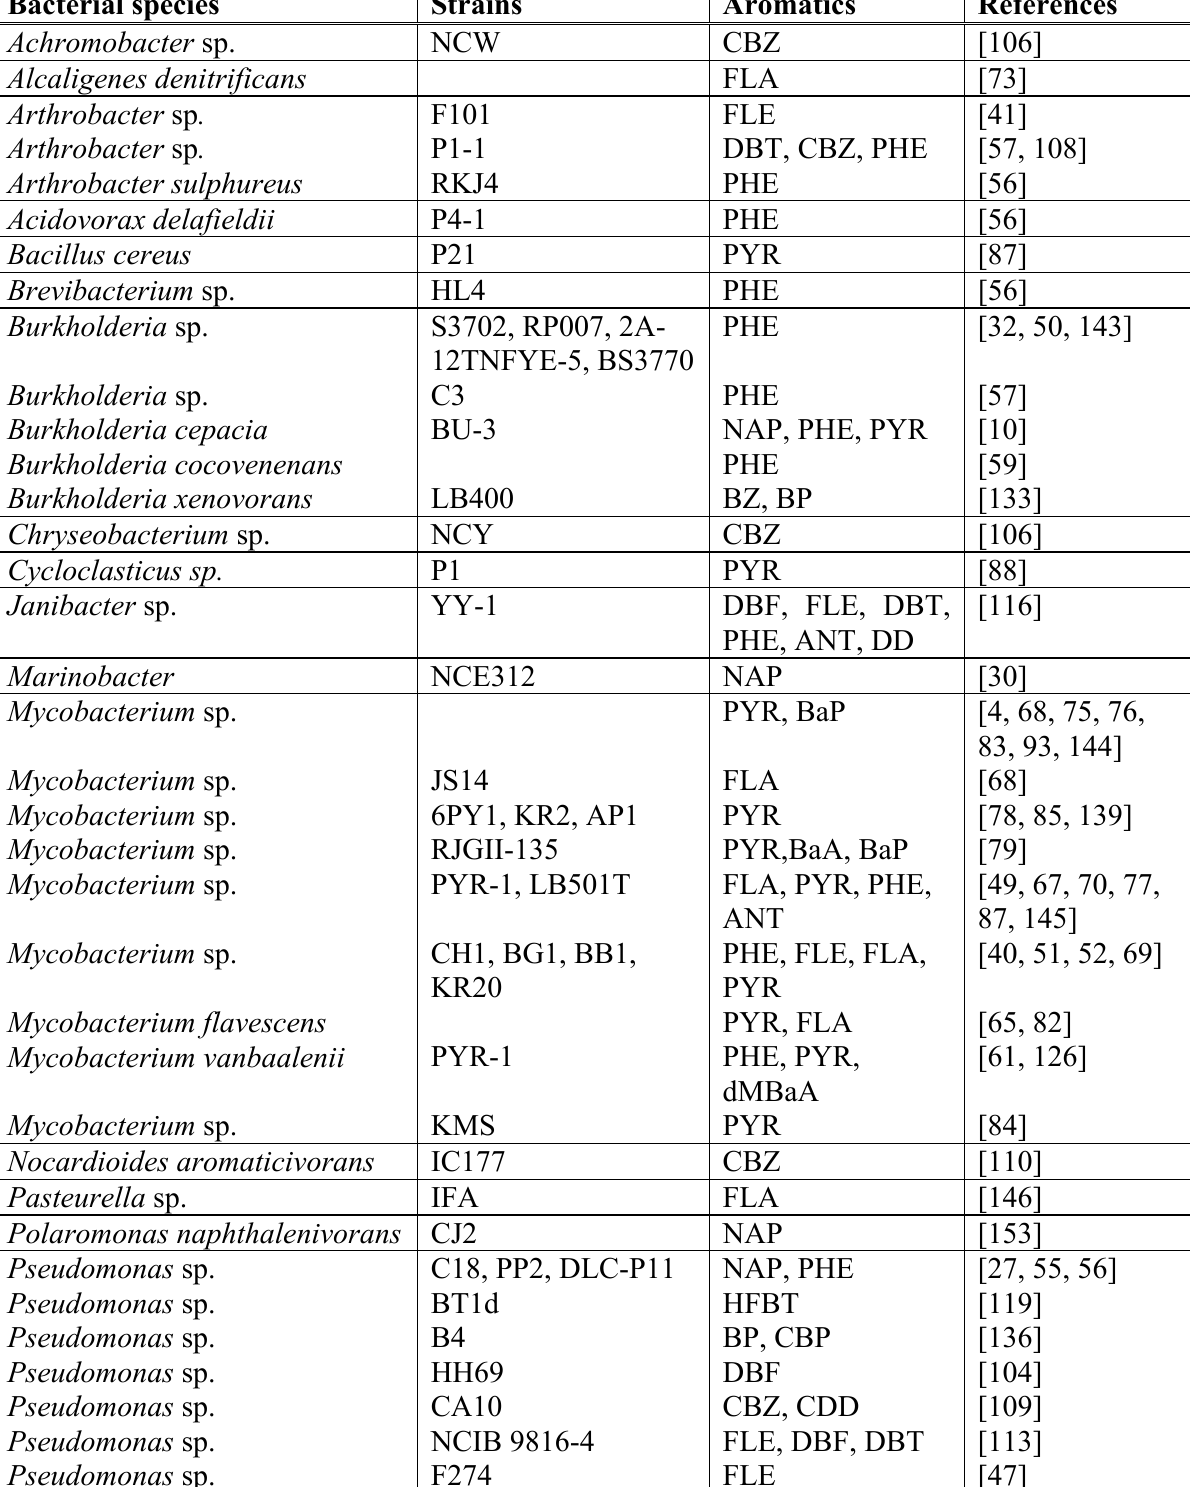
Table 1. Isolated bacteria capable of degrading aromatic compounds (incomplete list). Bacterial